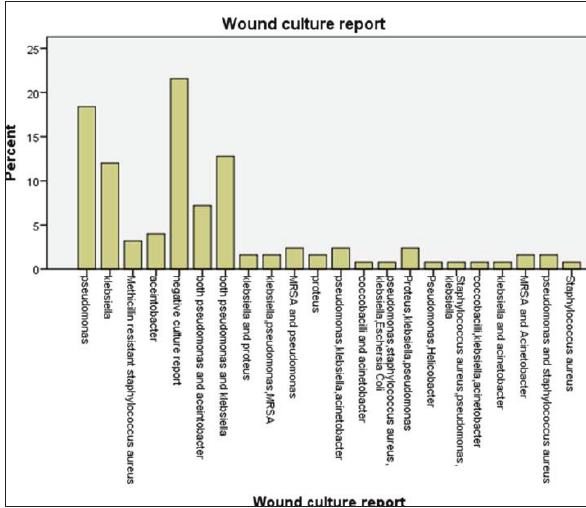
Figure 1: Wound culture report